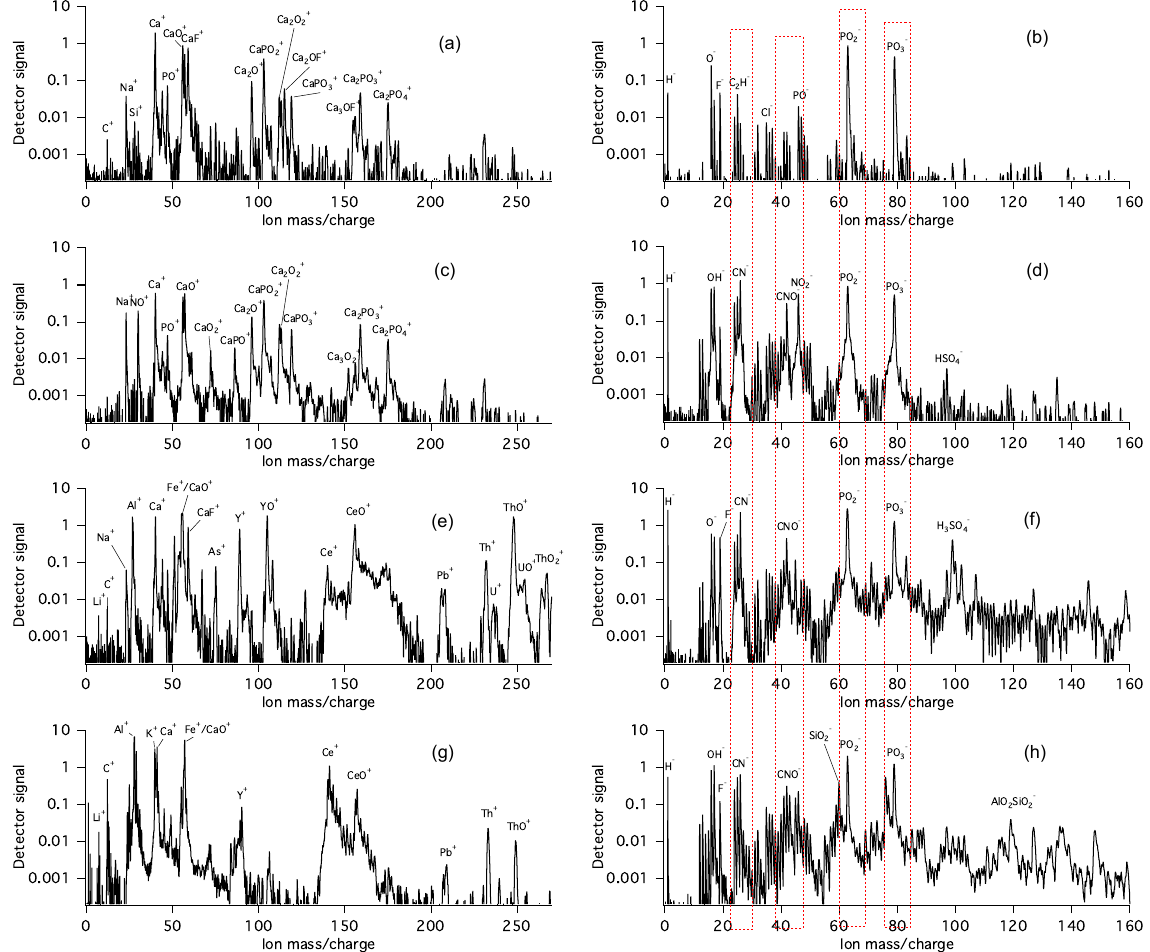
Figure 2. Representative PALMS spectra of phosphorus-rich minerals and ambient aerosol. (a, b) Unprocessed apatite. (c, d) Apatite pro- cessed with HNO 3 (see text for details). (e, f) Monazite-Ce. (g, h) Ambient particles sampled at Storm Peak matching monazite chemistry. Right and left columns are positive and negative polarity, respectively. Red dotted lines are features indicated in the literature as markers for biological